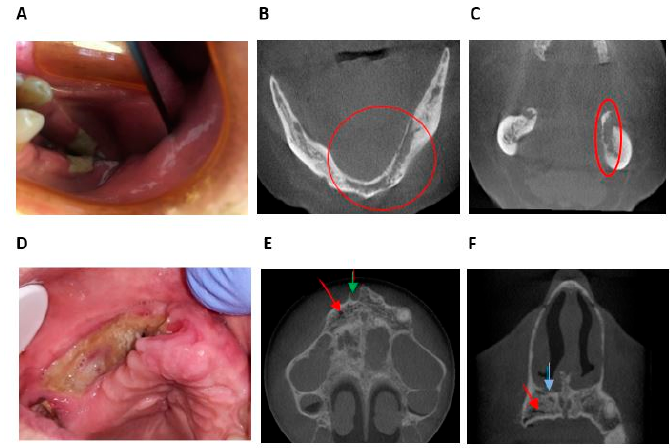
Figure 4. Example of the difference between the clinical extent and radiographic extent of osteonecrosis determined with CBCT. ( A ) Mr X: Intraoral view showing bone exposure 7 mm in the region of the left mandibular molar. ( B ) Mr X: CBCT image of axial section of the mandible, showing bone osteolysis and abnormalities from the incisor region to the left molar region. ( C ) Mr X: CBCT image of coronal section of the mandible showing bone osteolysis and abnormalities of the inner cortical and cancellous bone of the mandible. The radiological extent seems more important than the clinical extent. ( D ) Mrs Y: Intraoral view showing bone exposure with pus exudation from the right incisor region to the right molar region. ( E ) Mrs Y: CBCT image of axial section of maxillary showing dental socket after dental avulsion (green) and intraosseous air bubbles (red). ( F ) Mrs Y: CBCT image of coronal section of the mandible showing intraosseous air bubbles (red) and periosteal reaction (blue) in the right incisor-canine region. The radiological extent seems less important than the clinical extent.